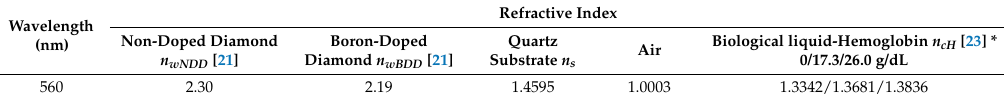
Table 1. The refractive index for each layer in modeled waveguide structure.